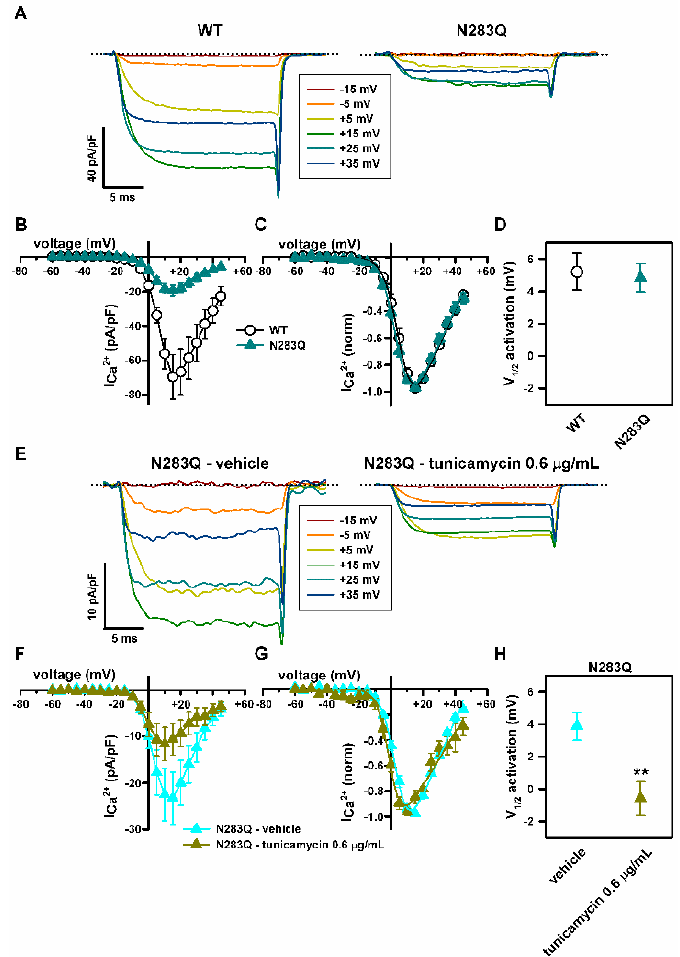
Figure 7. N283Q glycosylation site mutation reduces Ca 2+ current density through Ca V 2.1 channels heterologously expressed in HEK293 cells, without altering their voltage-dependent activation. ( A ) Current traces elicited by 20 ms depolarizing pulses from − 80 mV to the indicated voltages (inset) illustrating the decrease in Ca 2+ current density through Ca V 2.1 channels containing the mutation at the α 1A glycosylation site N283, which exhibit voltage dependence of activation similar to that of WT channels. Dotted lines mark the zero current level. Average Ca 2+ current density-voltage relationships ( B ) and normalized I-V curves ( C ) for WT (open circles, n = 13) and N283Q (filled dark cyan triangles, n = 19) Ca V 2.1 channels. N283Q reduces maximal Ca 2+ current density (obtained by membrane depolarization to +15 mV) from − 69.4 ± 12.9 pA/pF ( n = 13) to − 19.5 ± 3.2 pA/pF ( n = 19) ( p < 0.001, Mann-Whitney U -test). ( D ) N283Q mutation has no significant effect on the V 1/2 for Ca V 2.1 channel activation (estimated from normalized I-V curves shown in C as indicated in Materials and Methods, p = 0.798, Student’s t -test). ( E ) Current traces elicited by 20 ms depolarizing pulses from − 80 mV to the indicated voltages (inset) illustrating the shift of activation to lower depolarization induced by 0.6 μ g/mL tunicamycin on N283Q mutant Ca V 2.1 channels containing β 3 and α 2 δ 1 subunits. The zero current level is indicated by dotted lines. Average Ca 2+ current density-voltage relationships ( F ) and normalized I-V curves ( G ) for N283Q mutant Ca V 2.1 channels expressed in DMSO-treated cells (filled cyan triangles, n = 10) and in cells treated with 0.6 µ g/mL tunicamycin (filled green circles, n = 8). Peak Ca 2+ current density through N283Q Ca V 2.1 channels after vehicle (DMSO) and tunicamycin treatments were − 23.3 ± 5.6 pA/pF ( n = 10) and − 11.6 ± 3.6 pA/pF ( n = 8), respectively ( p = 0.06, Student’s t -test). ( H ) Reduction in V 1/2 for activation of Ca V 2.1 channels composed by N283Q mutant α 1A , β 3 and α 2 δ 1 subunits (estimated from normalized I-V curves shown in ( G ) as indicated in Materials and Methods) produced by 0.6 µ g/mL tunicamycin ( n = 8). ** p < 0.01 versus the control condition (vehicle, n = 10; Student’s t -test).